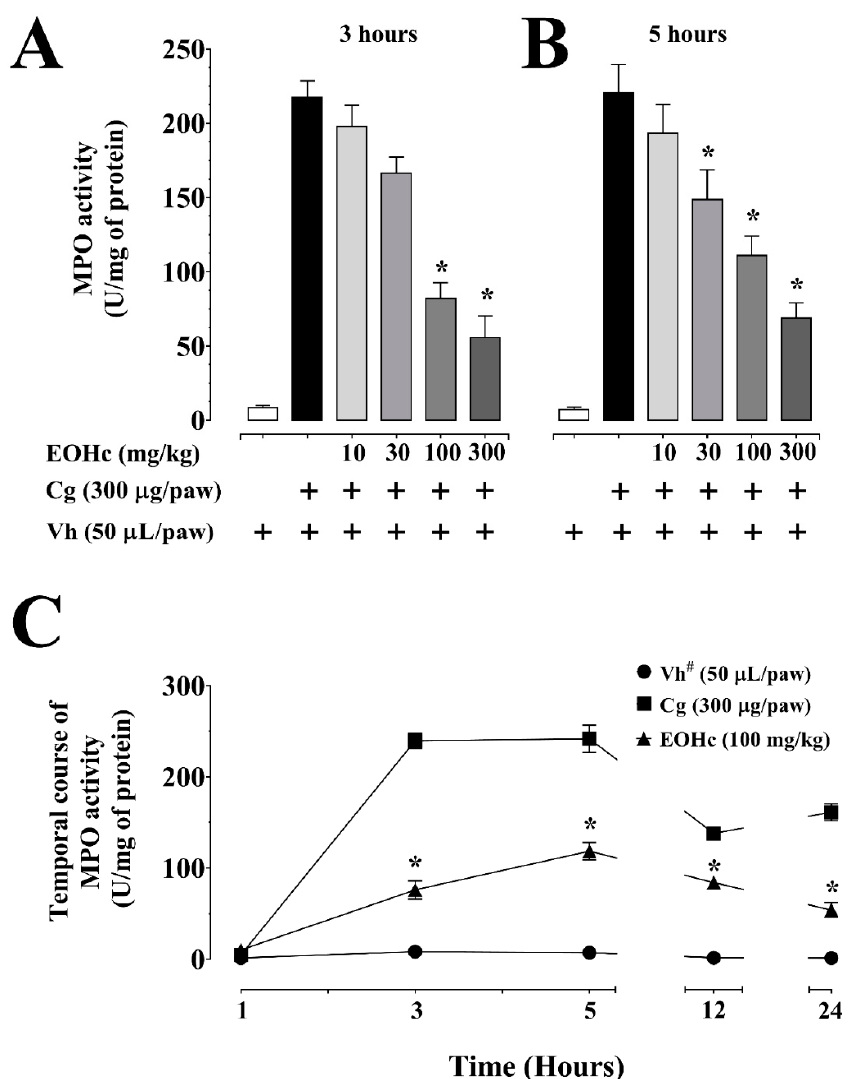
Figure 2. Inhibitory effects of essential oil of Hyptis crenata (EOHc) on myeloperoxidase (MPO) activity. EOHc or the vehicle (0.1% Tween 80) was administered, orally, 1 h before carrageenan intra-plantar injection for edema induction. Effect of EOHc (10–300 mg/kg, p. o.) at 3 h ( A ), and at 5 h ( B ) of intra-plantar injection of carrageenan (Cg, 300 µg/paw) or of its vehicle (Vh, 0.9% NaCl solution, 50 µL/paw). ( C ), effect of EOHc (100 mg/kg, p. o.) on temporal course (1–24 h) of intra-plantar injection of carrageenan. The MPO dosage was normalized by protein amount (mg). #, vehicle only. *, p < 0.05, vs. control, carrageenan (One-way or two-way ANOVA followed by Bonferroni’s test). n (number of animals) = 8–10 for all panels. “+” means in presence of.